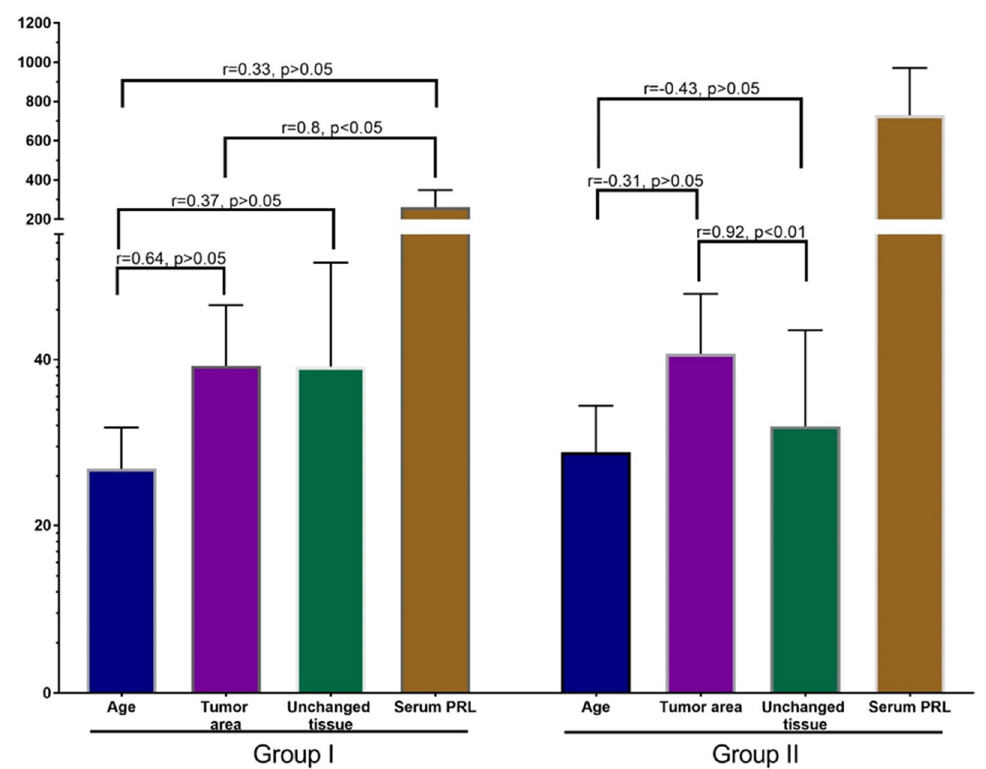
Figure 6. Correlation analysis of patients’ age, PRL-R expression in BBT and adjacent tissue, and serum PRL. Values: age—years, PRL-R—IHC-positive cells per FOV, Serum PRL—mU/L.